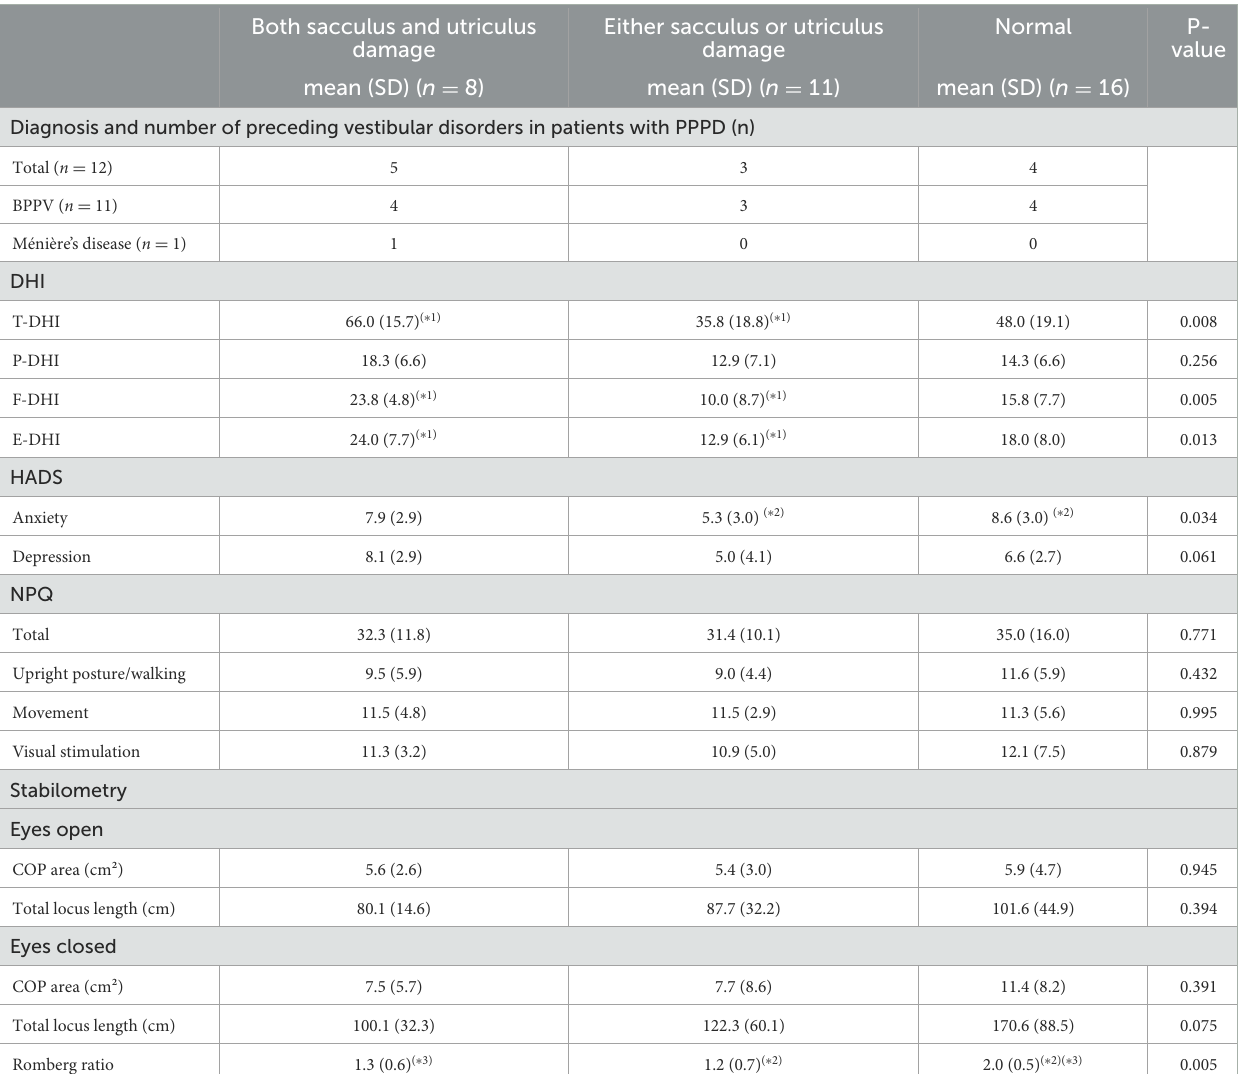
TABLE 5 Three-group comparison of the both sacculus and utriculus damage iOtoDys group, the either sacculus or utriculus damage iOtoDys group, and the normal group. Both sacculus and utriculus Either sacculus or utriculus Normal P- damage damage value mean (SD) ( n = 8) mean (SD) ( n = 11) mean (SD) ( n =